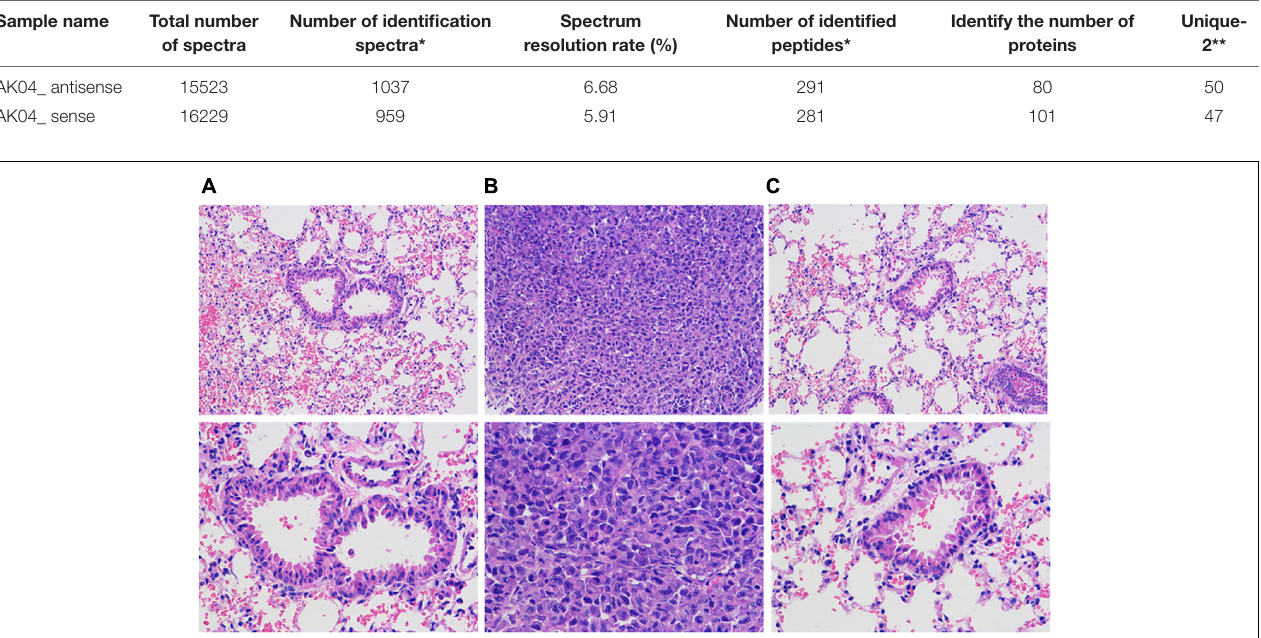
FIGURE 9 | HE staining to observe the pathological changes of lung and lung metastases in nude mice with breast cancer (HE staining, 200X). (A) Normal breast cancer cells, (B) InCRINA TPA overexpression cells, (C) IncRNA TPA knockdown cells.